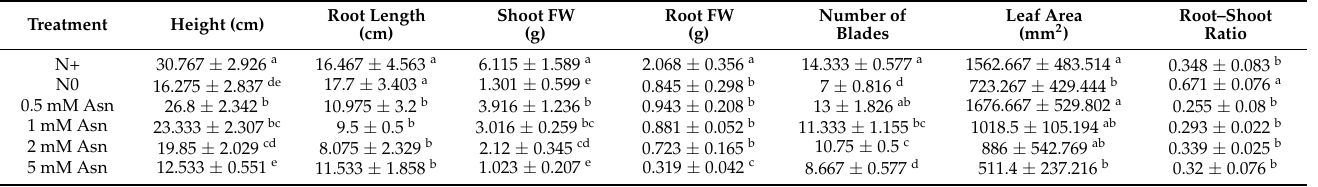
Table 1. Physiological effects of exogenous asparagine (Asn) on poplar ‘Nanlin895’ growth. Treatment